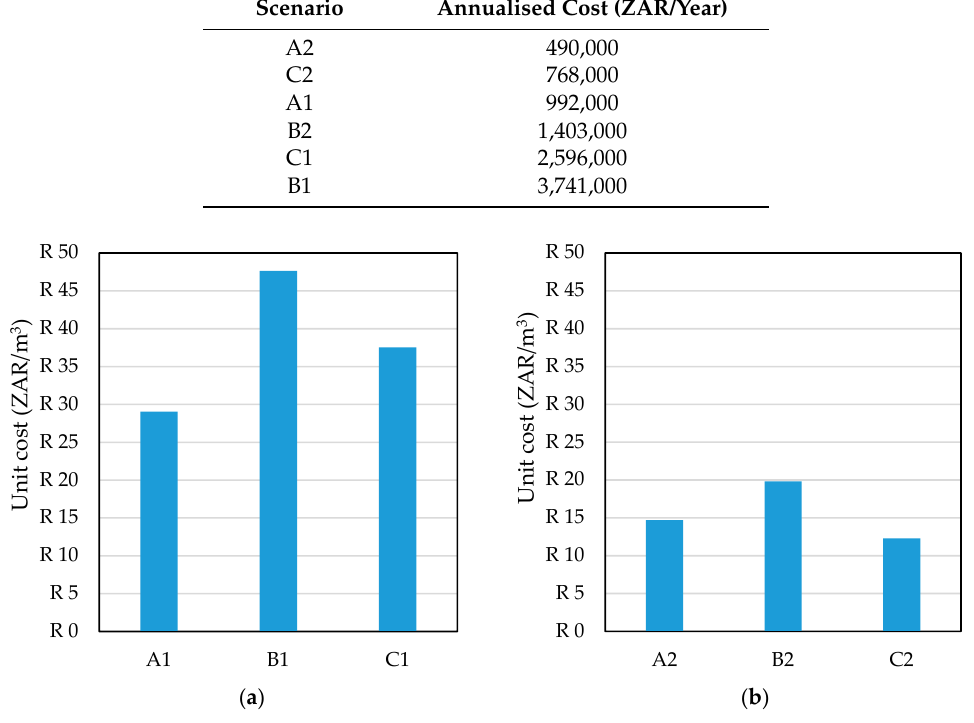
Figure 5. Comparison of unit cost for each SWH scenario of supplying stormwater for: ( a ) toilet flushing only (WDA 1); and ( b ) toilet flushing, clothes washing and lawn irrigation (WDA